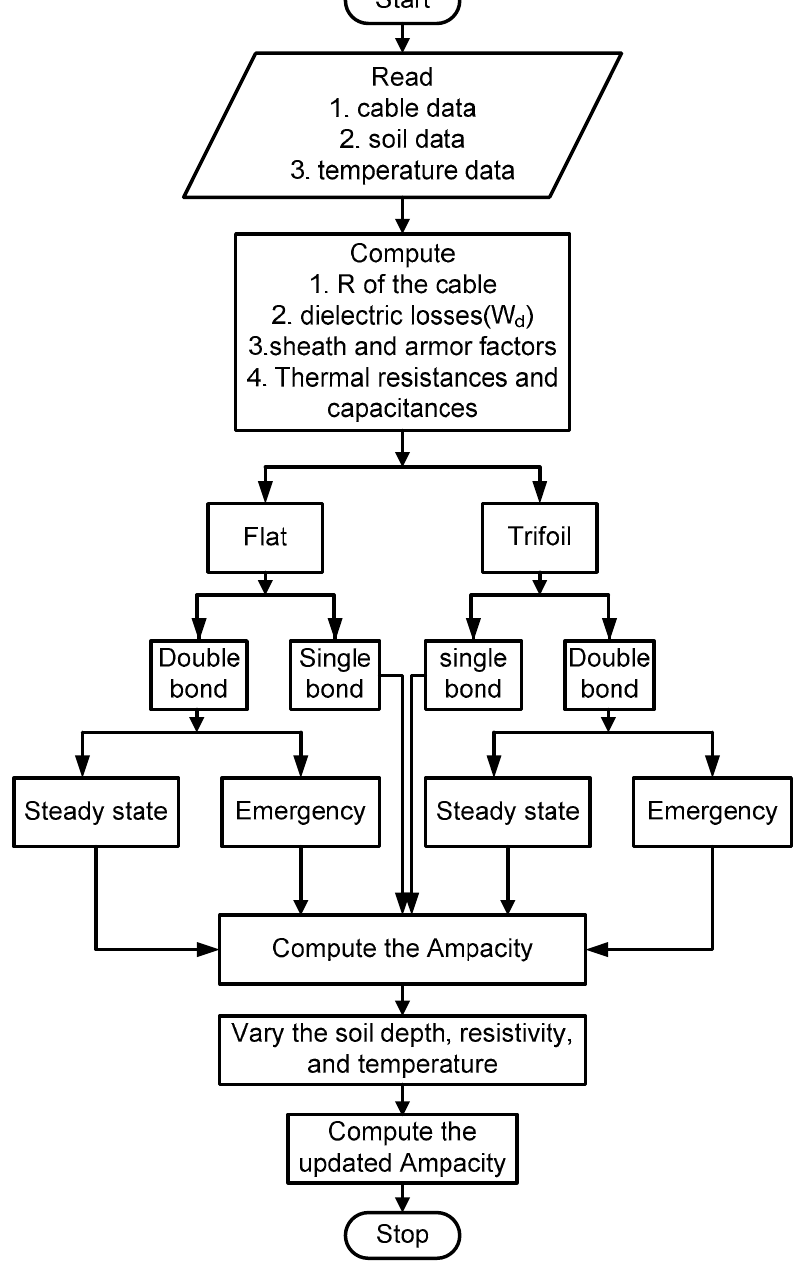
Figure 6. The ampacity computation flowchart.